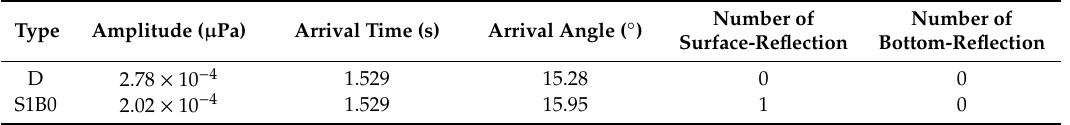
Table 1. Structure of D and S1B0 wave.